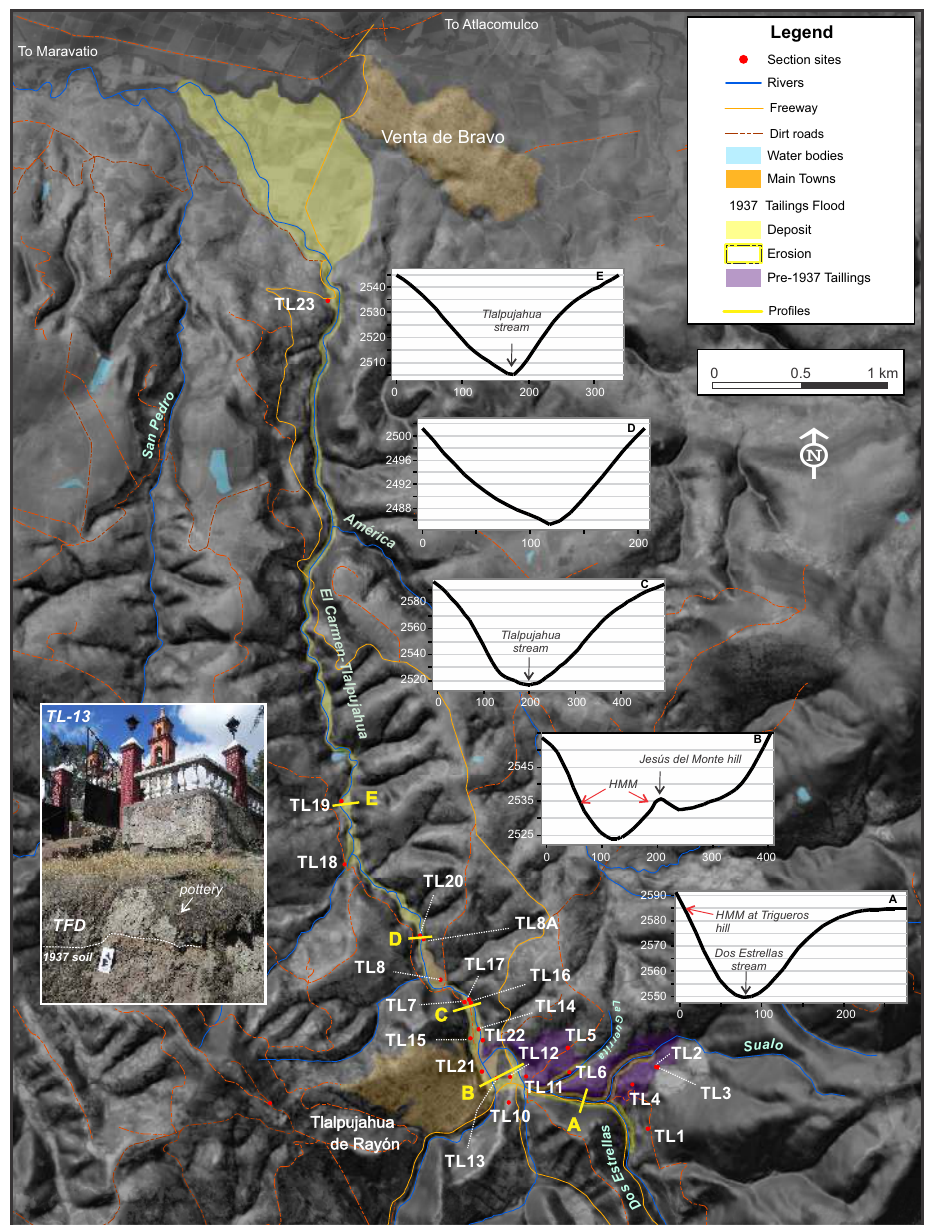
Figure 8. Shaded relief map of the MDOT displaying the location of Tlalpujahua and Venta de Bravo villages, the extension of Los Cedros tailings in 1937, and the present extension of the 1937 flood deposit. Red circles are stratigraphic sections measured during this study. Insets are cross profiles indicating the shape of the flow channel and some flow indicators as high-mud